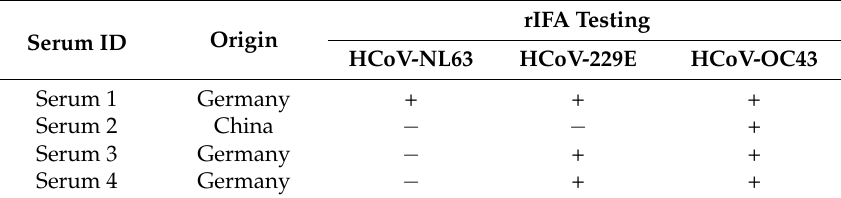
Table 2. Profile of Coronavirus-characterized sera. rIFA Testing Serum ID Origin HCoV-NL63 HCoV-229E HCoV-OC43 Serum 1 Germany + + + Serum 2 China Serum